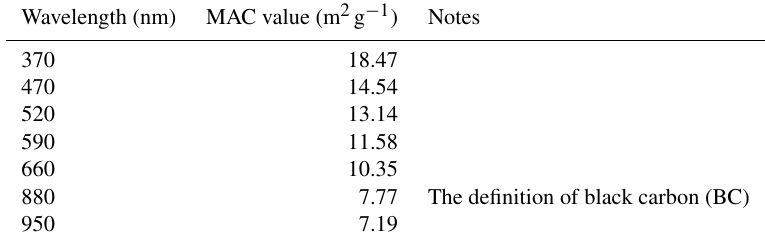
Table A1. Factory mass absorption cross-section (MAC) coefficients for the AE33 aethalometer (Magee Scientific, 2016).